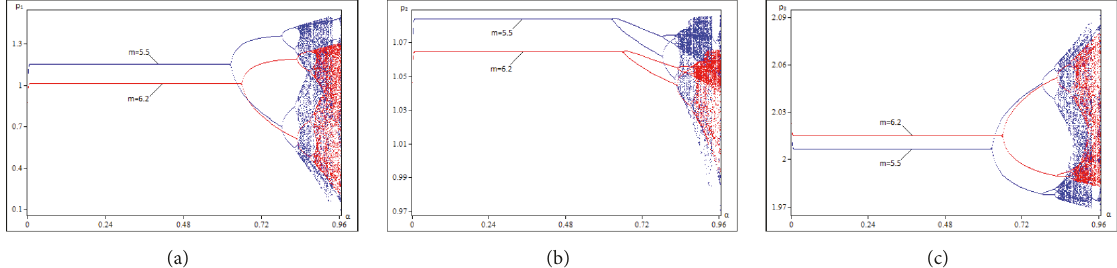
Figure 7: (a) Bifurcations of 𝑝 1 when 𝑚 = 5.5 and 6.2, (b) bifurcations of 𝑝 2 when 𝑚 = 5.5 and 6.2, and (c) bifurcations of 𝑝 3 when 𝑚 = 5.5 and